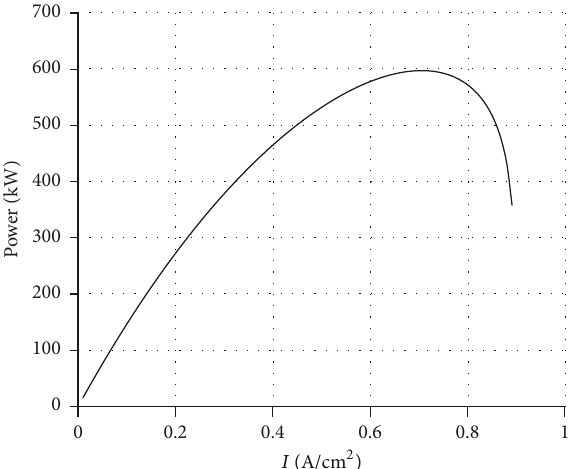
Figure 8: Variation of IRSOFC power production versus current density (first